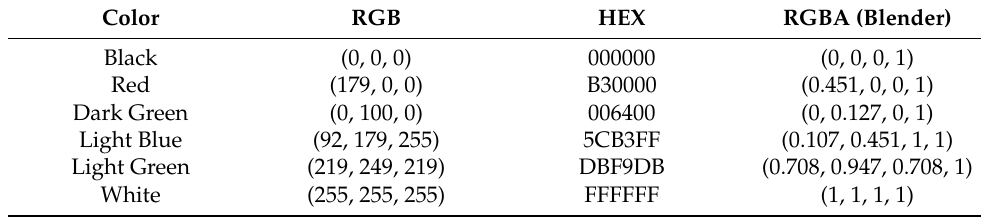
Table 1. Colors that were used for the coffee maker 3D model. Color